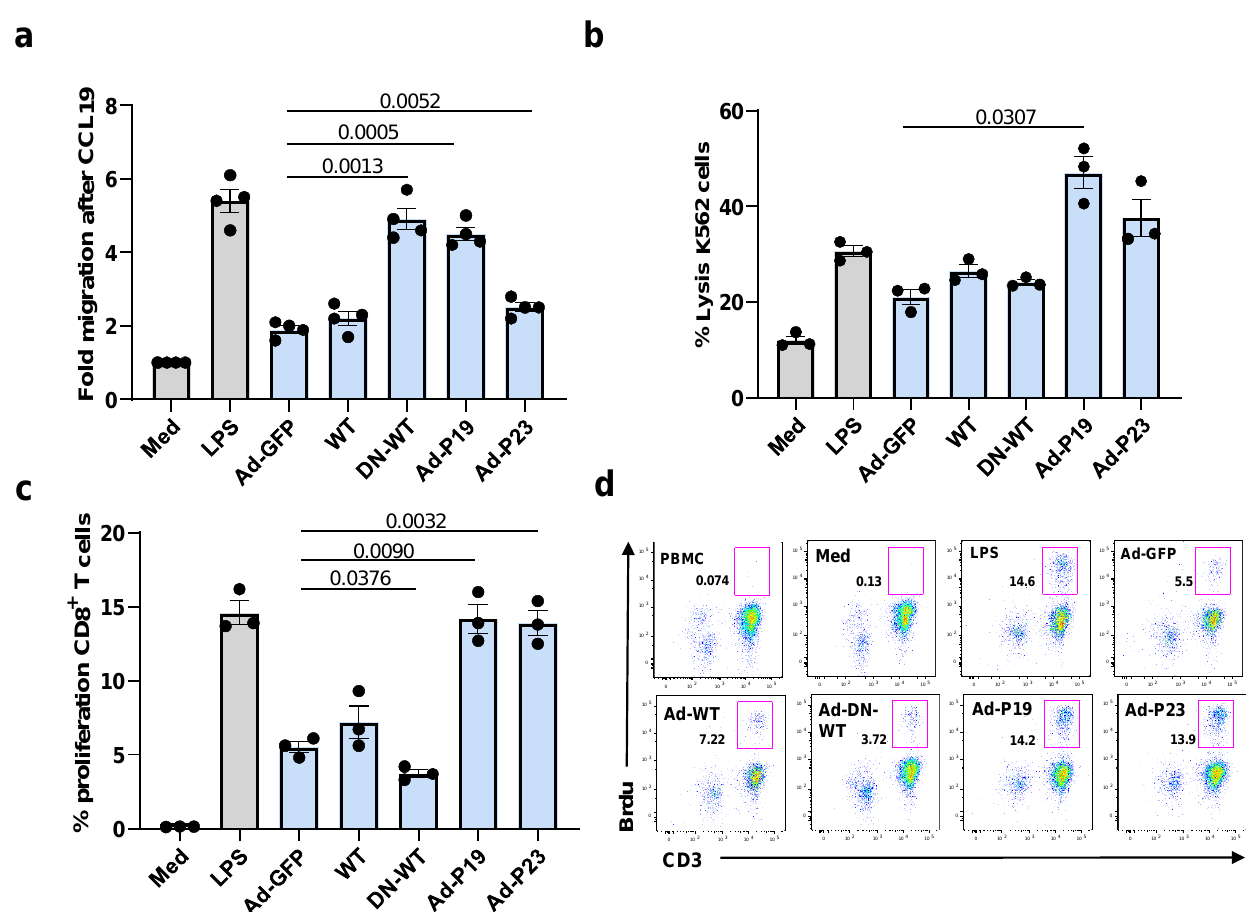
Figure 3. P19 and P23 enhance the migration and activation of Mo-DCs to CCL19 in vitro. ( a ) Migration assay of Mo-DC (5 × 10 4 cells in 50 µ L, top chamber) stimulated with LPS alone (positive control) or in the presence of Ad-GFP, Ad-P19, Ad-P23, Ad-DAP12, or Ad-DN-DAP12 in a micro-chemotaxis chamber. The bottom chambers were filled with serum-free medium with or without CCL19 (100 ng/mL). DC migration rates were determined by counting Diff-Quick stained cells trapped in the filter. The figure represents the fold difference were the experimental control is Med (1) and the background controls is CCL19 untreated cells. ( b ) Mo-DCs as in “a” were pulsed with K562 lysates, treated with mitomycin c and co-cultured with PBMC (2.0 × 10 5 cells/well). After stimulation, 51 Cr-labeled target K562 tumor cells were used in a cytotoxicity ( 51 Cr-release) assay at an effector:target ratio of 20 to 1. ( c ) The specific proliferation of CD8 + T cells in experiment in “b” by BrdU incorporation via flow cytometry. ( d ) Proliferation of total CD3 + T cells was measured by Brdu incorporation (representative figure of n = 3). Student t-test analysis is shown. ANOVA analysis p values are in Supplemental Table